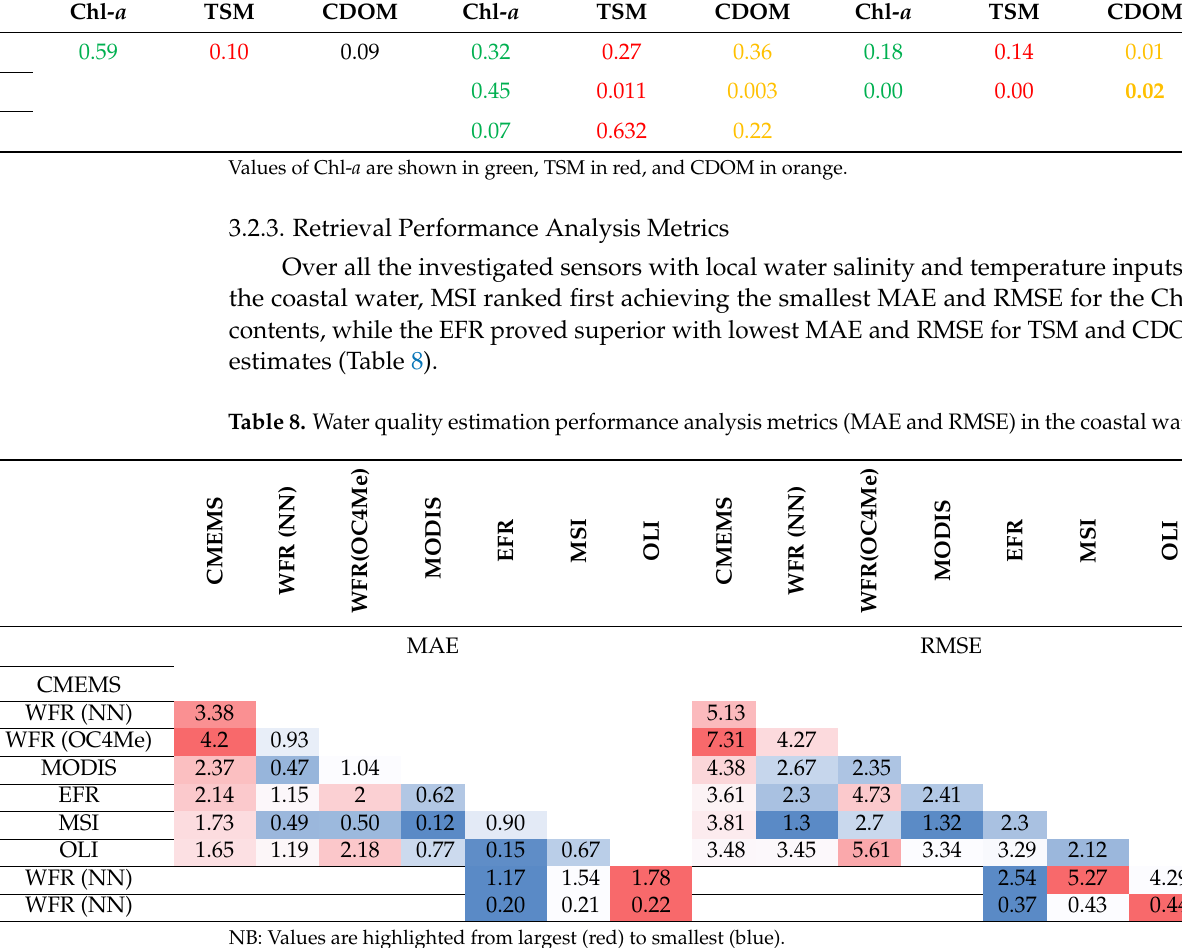
Table 7. Coefficients of determination ( R 2 ) of the retrieved parameters in Lake Burullus ( n = 30). .